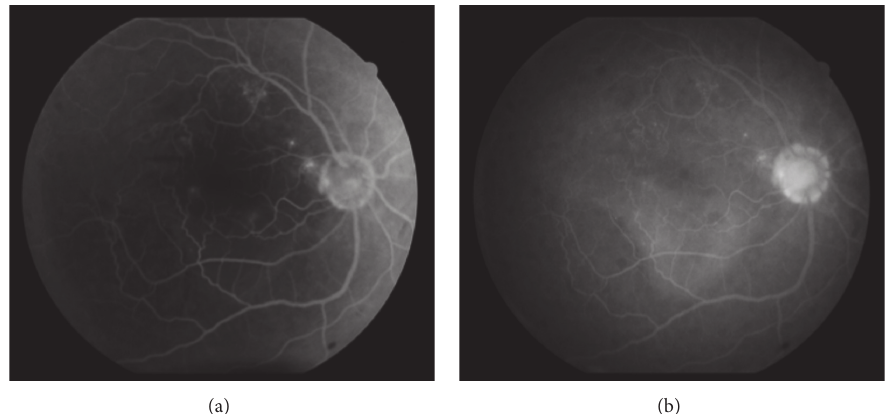
Figure 2: Fundus fluorescein angiography of the same eye in venous phase showing multiple focal leaks at the macula (a) and pooling of dye in the subretinal space in late phase (b).